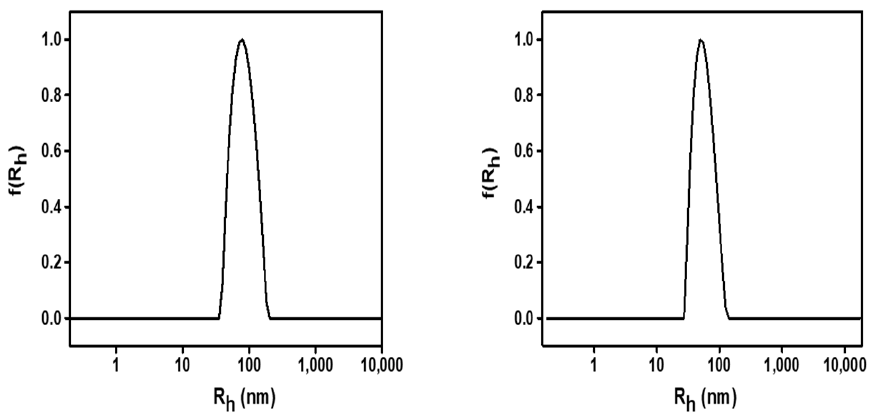
Figure 1. Size distribution from CONTIN analysis for Sample 1b ( left ) and 1d ( right ) at 90°. Data was collected on day 1.